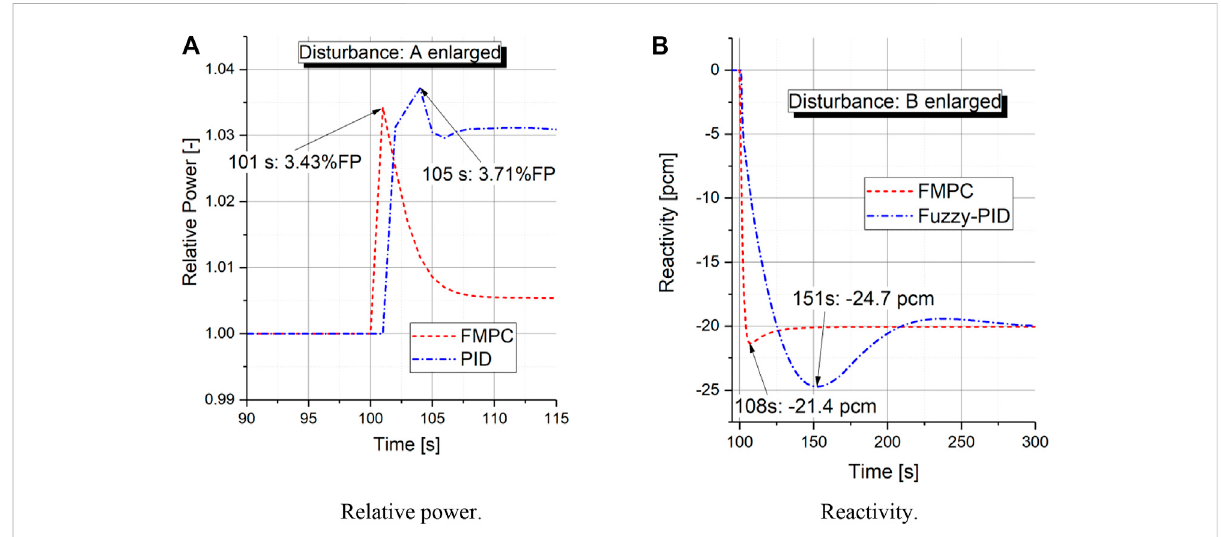
Enlarged view of the area A and B for the disturbance transient. (A) Relative power. (B) Reactivity.